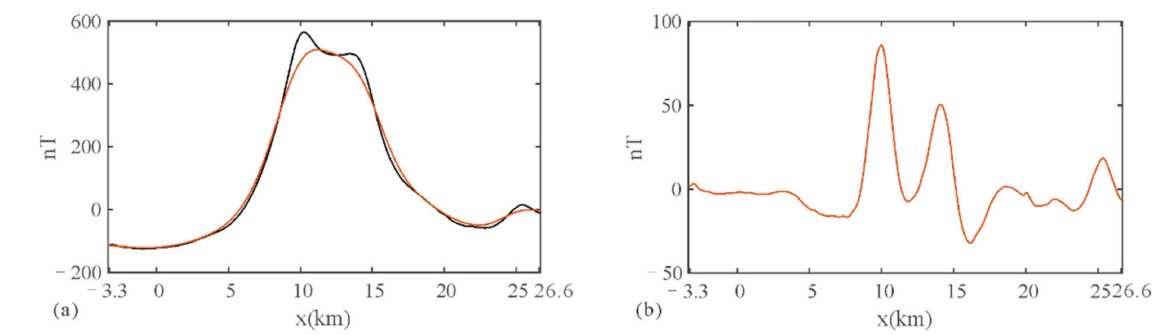
Figure 9. A profile at y = 16 km in the west-east direction in the magnetic RTP data of Qihe area: ( a ) the black and yellow lines represent the RTP data and the background field data; ( b ) the yellow line represents the magnetite-caused data.